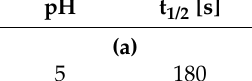
Table 1. ( a ) Half ‐ life of Succinimidyl Iodoacetate (SIA) at different pH values; ( b ) Half ‐ life of N ‐ ( β‐